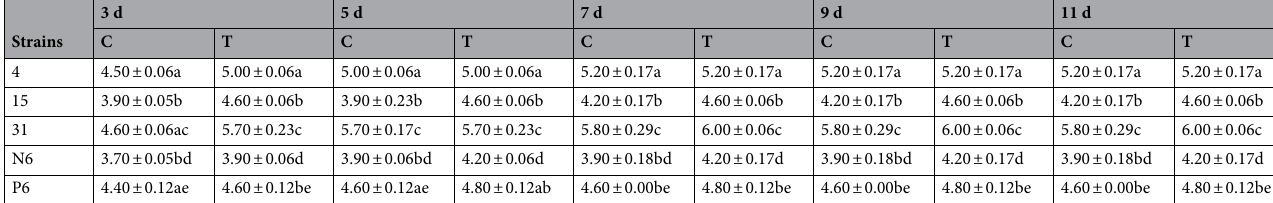
Table 2. Diameter changes of colony and transparent circles of different strains on selective media indicating cellulose degradation ability over time (cm). C is for Circle of the colony; T is for transparent circle. Mean values are marked with different lower case letters are significantly different ( P < 0.05).